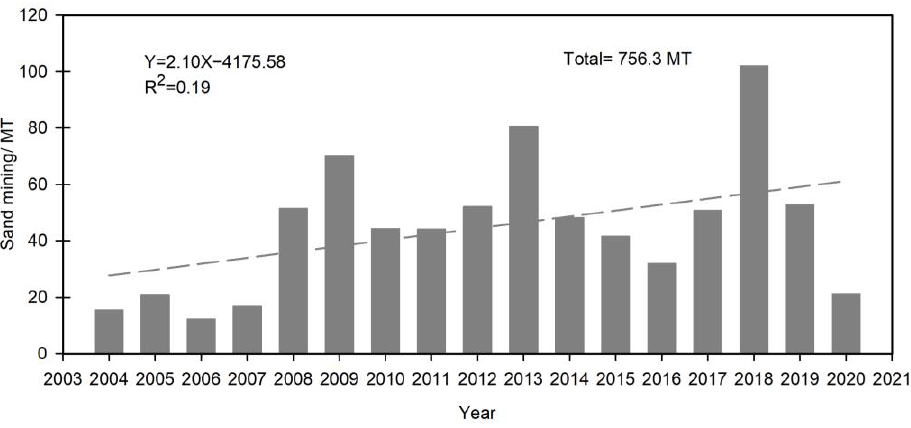
Table 5. Planned data of sand mining in the tributaries of the YR.